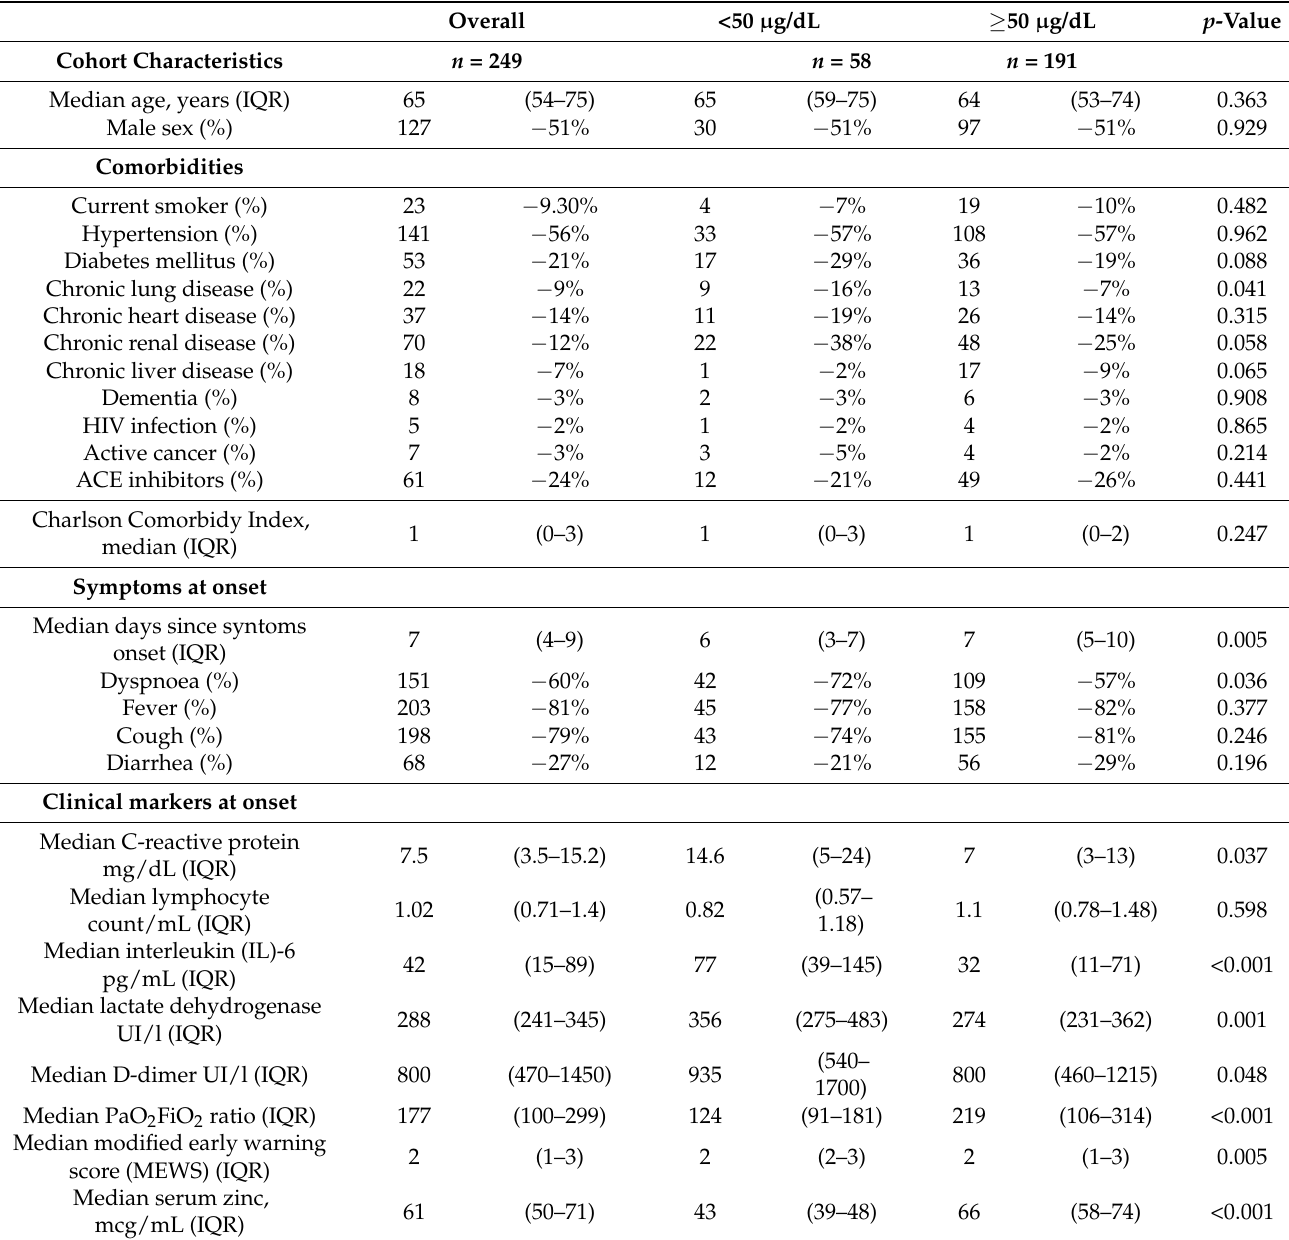
Table 1. Main clinical characteristics of the cohort. Differences between individuals with plasma zinc at admission at <50 mcg/dL and ≥ 50 mcg/dL.